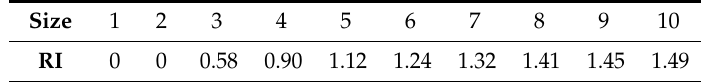
Table 2. The average consistencies of random matrices (The Random